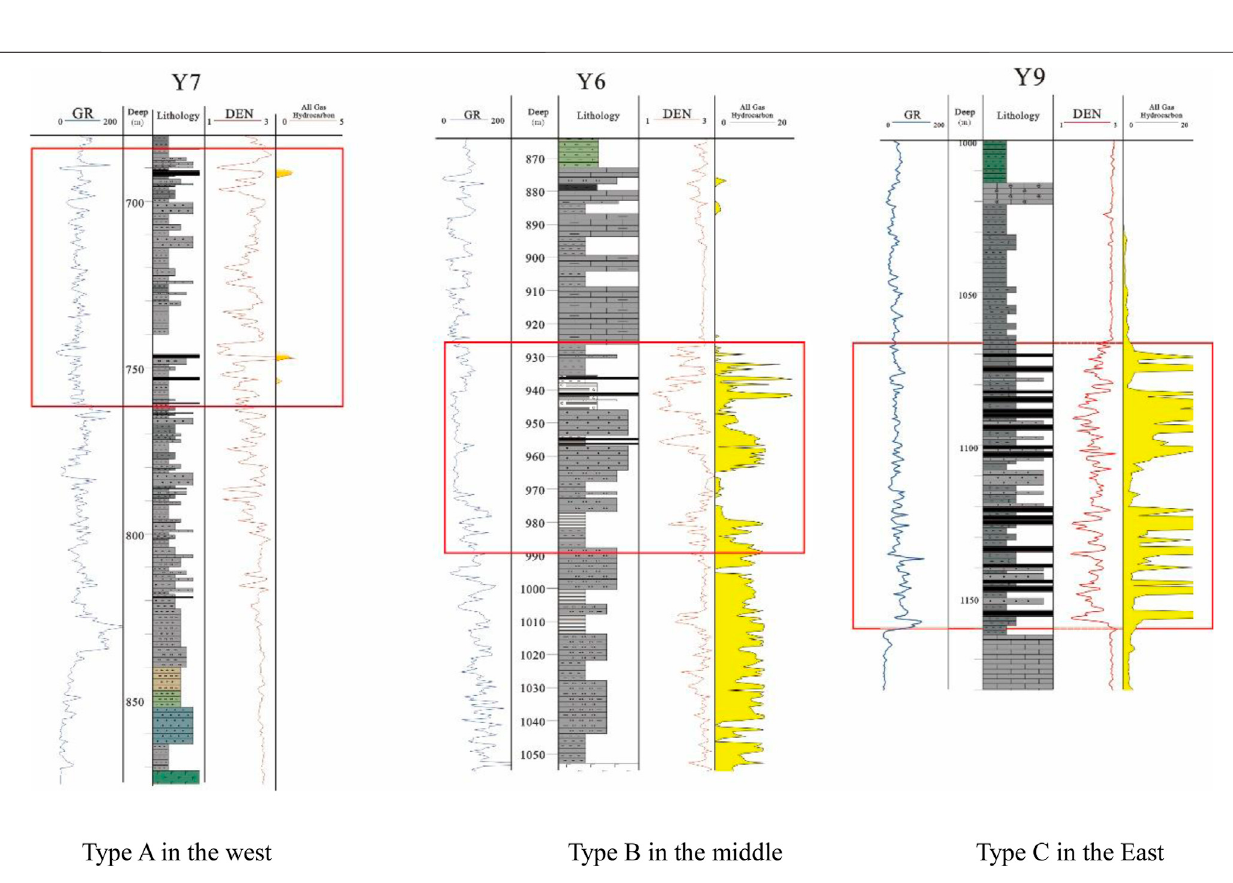
Frontiers in Earth Science |